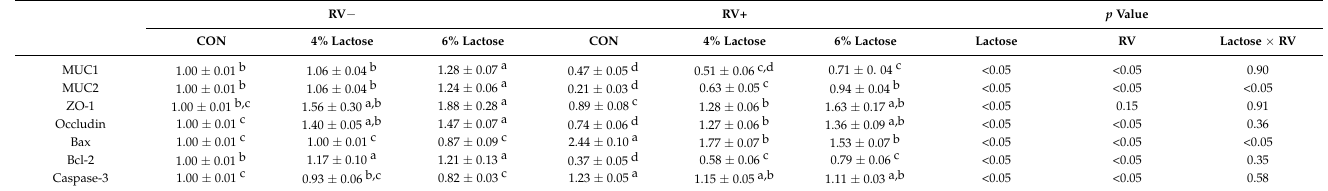
Table 9. Effect of dietary lactose supplementation and/or RV challenge on the mRNA expression of barrier-related and apoptosis-related genes in the jejunal mucosa of weaned pigs 1 . RV − RV+ p Value